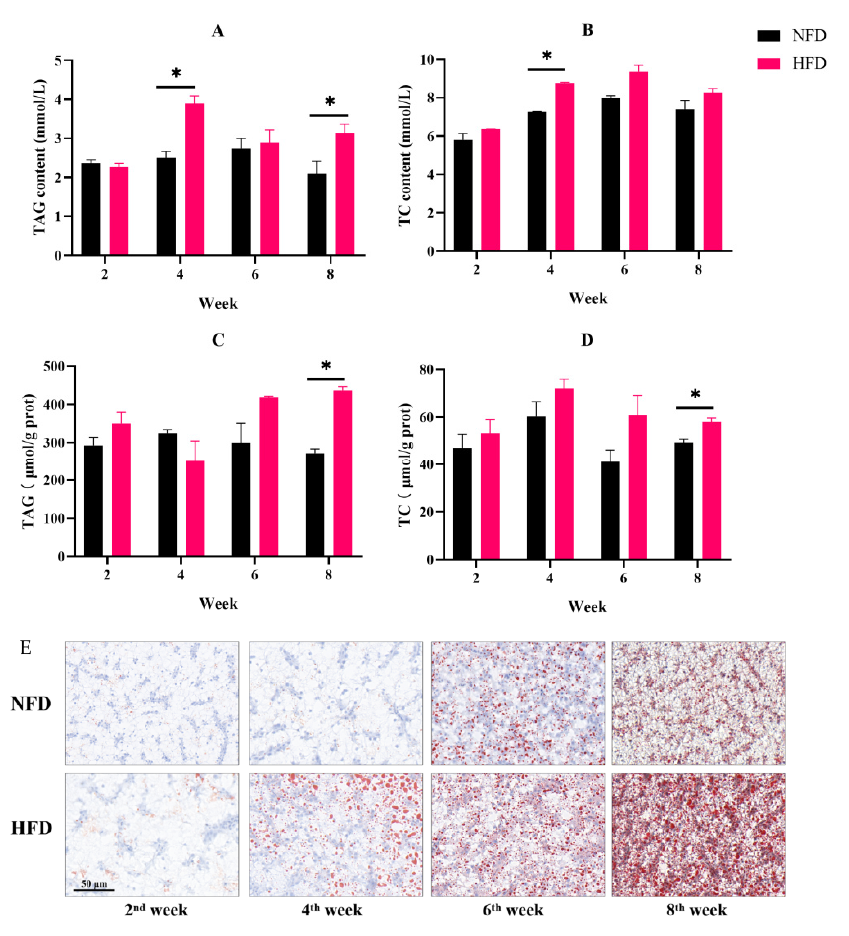
Figure 2. Experiment I. ( A ) Serum TAG content. ( B ) Serum TC content. ( C ) Hepatic TAG content. ( D ) Hepatic TC content. ( E ) Liver oil red O-staining (( E ) scale bar = 50 µ m). “*” indicates a significant difference between groups ( p < 0.05, Student’s t -test, n = 3).